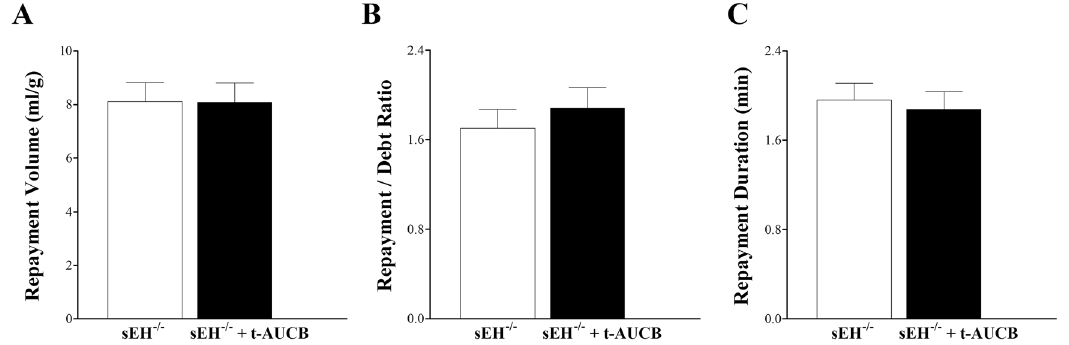
Fig 2. Effect of sEH-inhibitor, t -AUCB, on coronary reactive hyperemia (CRH) in sEH-null (sEH – / – ) mice. t -AUCB did not (p > 0.05) affect CRH in sEH – / – mice, as evident in the unchanged repayment volume (A), repayment/debt ratio (B), and repayment duration (C) (p = 0.690). n =